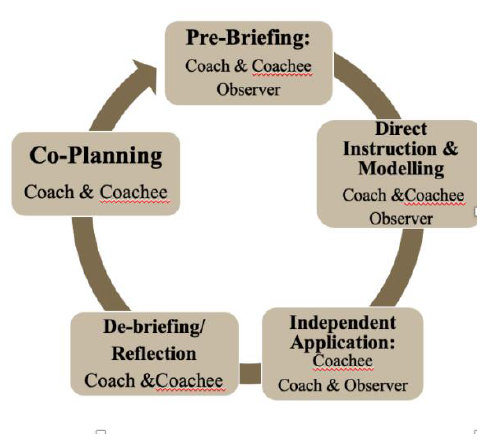
Figure 3: Literacy Coaching